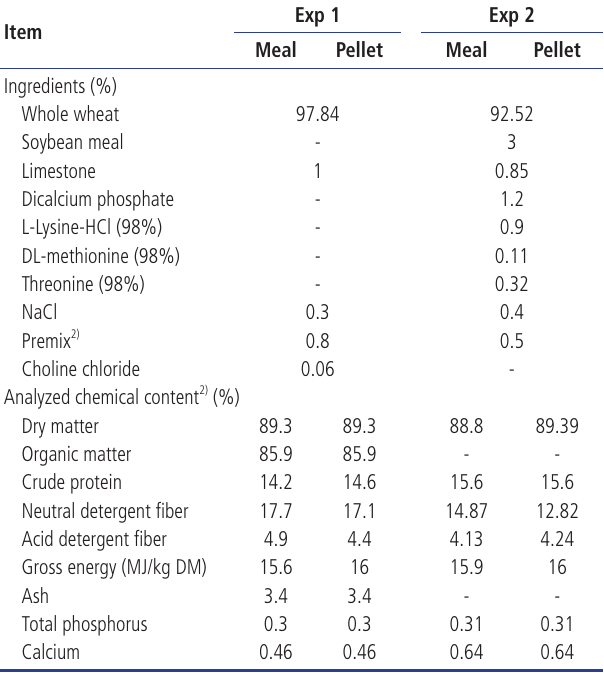
Table 1. Experimental diet composition and nutrient content 1) (as fed basis)